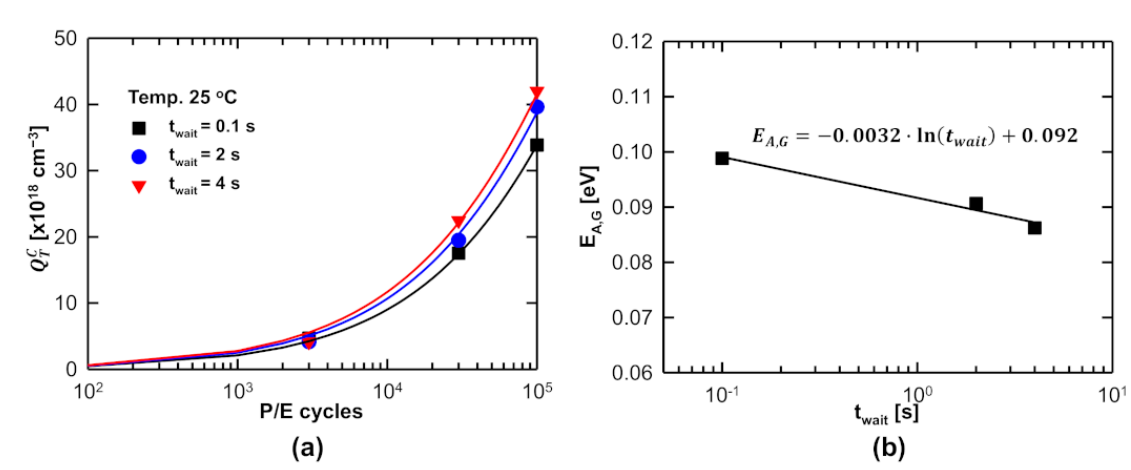
Figure 15. ( a ) Q C obtained by fitting experimental data using Equation (3) for different values of t wait . ( b ) Extracted E A , G T for different values of t wait . Reprinted from